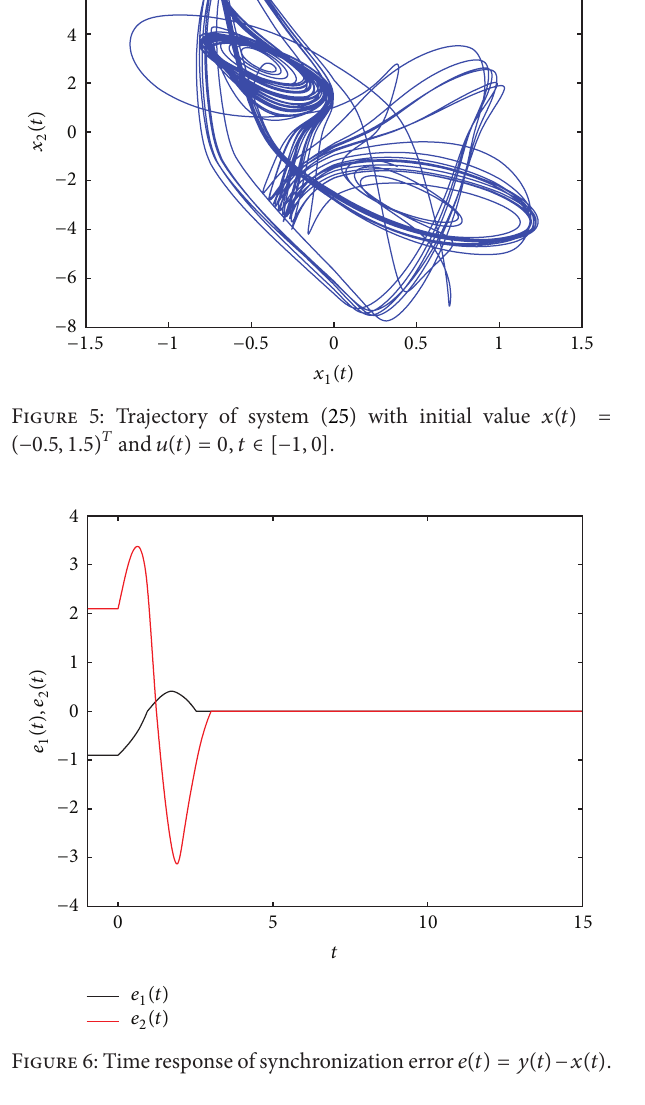
Figure 8: Trajectories of control parameters 𝛽 1 (𝑡) and 𝛽 2 (𝑡)